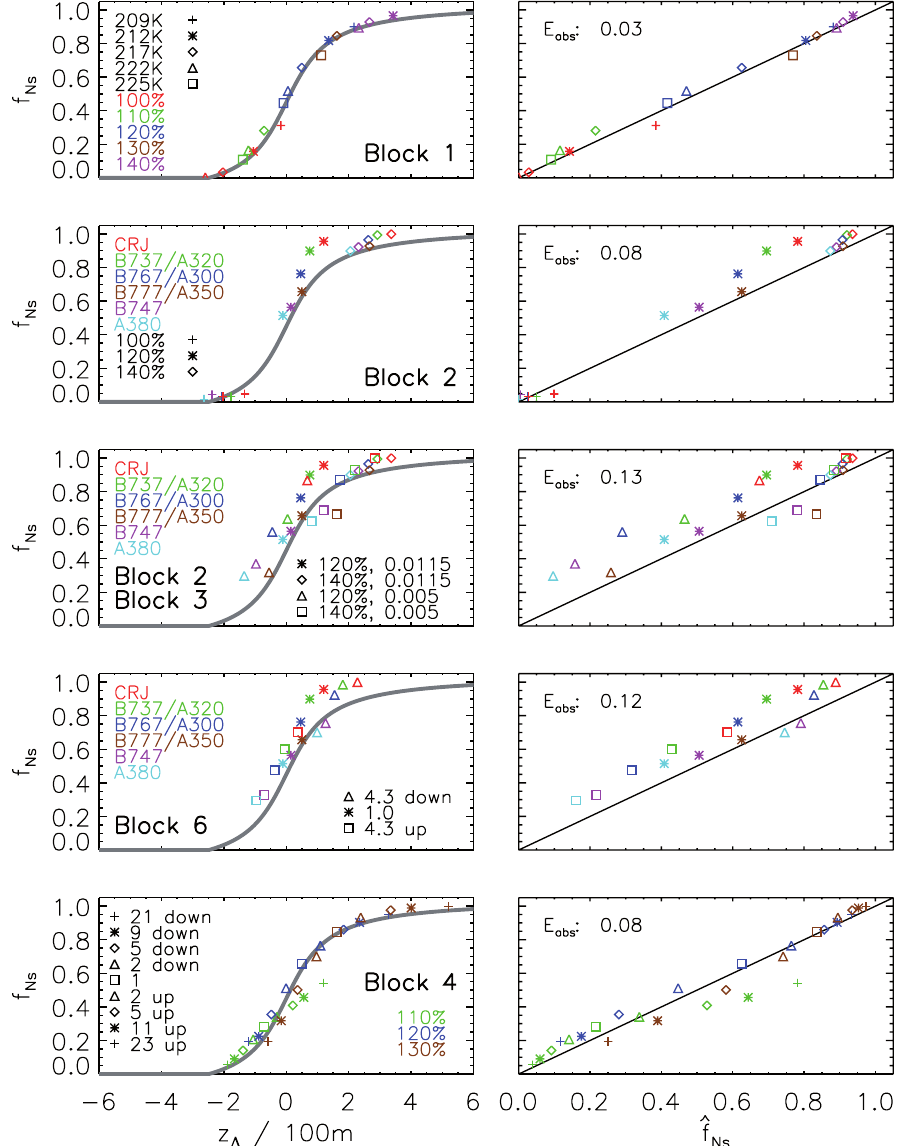
Figure 5. Left: relationship between simulated survival fraction f Ns and z (cid:49) . The grey curve shows the fit function ˆ a as defined in Eq. (9). Right: relationship between simulated survival fraction f Ns and approximated survival fraction ˆ f Ns . The black line shows the 1–1 line. Each row shows a subset of simulations taken from various simulation blocks defined in Table A2. For example, the first row shows simulations of block 1, where RH i and T CA are varied. The legend in the plot provides a list of the symbols and colours, which uniquely define the simulations parameters of each plotted data point. The root mean square of the absolute error ˆ f Ns − f Ns is denoted as E abs and given for each